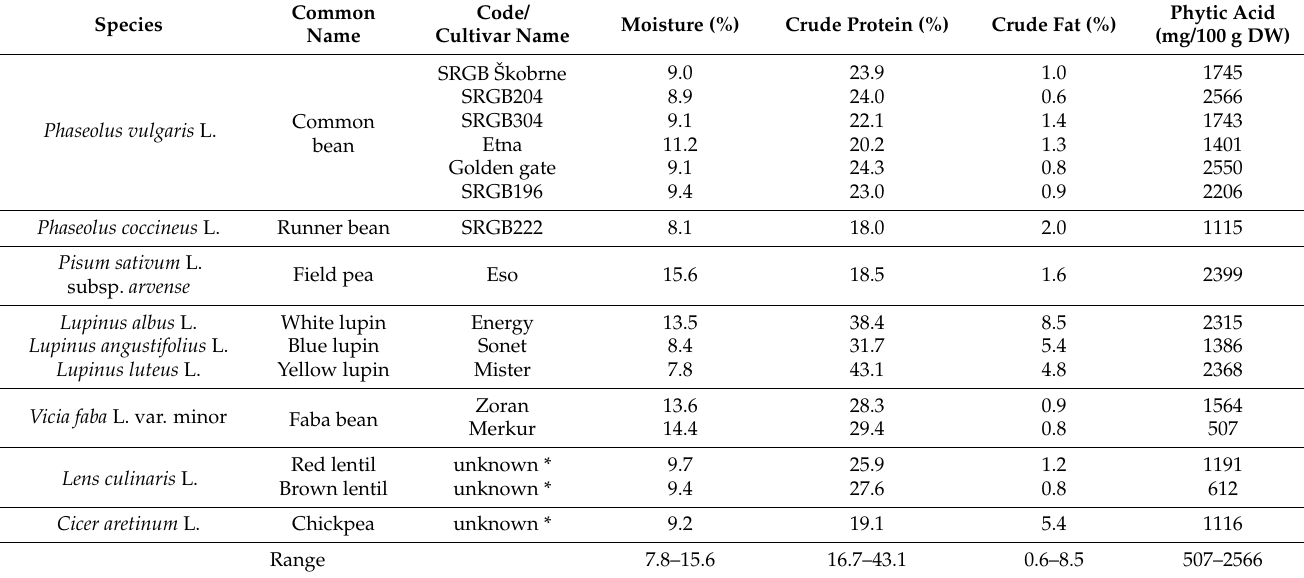
Table 1. Nutritional properties and phytic acid content in the seeds of studied